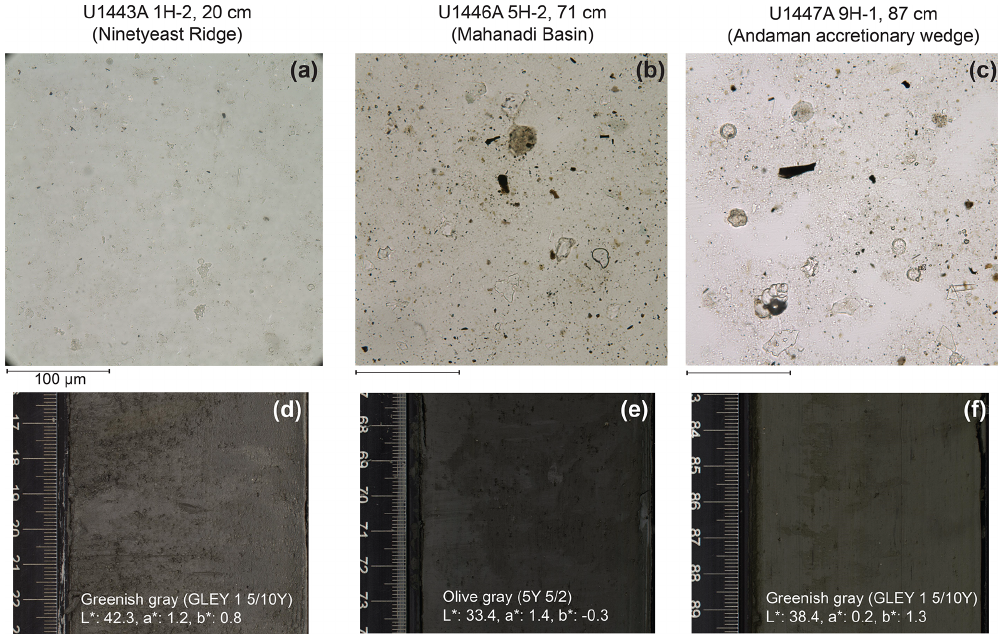
Figure 10. Smear slides from IODP Sites U1443 (a) , U1446 (b) , and U1447 (c) under plane-polarized light. Slides from Andaman Sea sites generally appeared lighter and more dominated by carbonate minerals compared to Mahanadi Basin sites. There are slight differences in sediment color, including Munsell soil color, lightness (L*), and hue-chroma coordinates (a* and b*) (d, e, f) . Data from Clemens et al. (2016b, c,